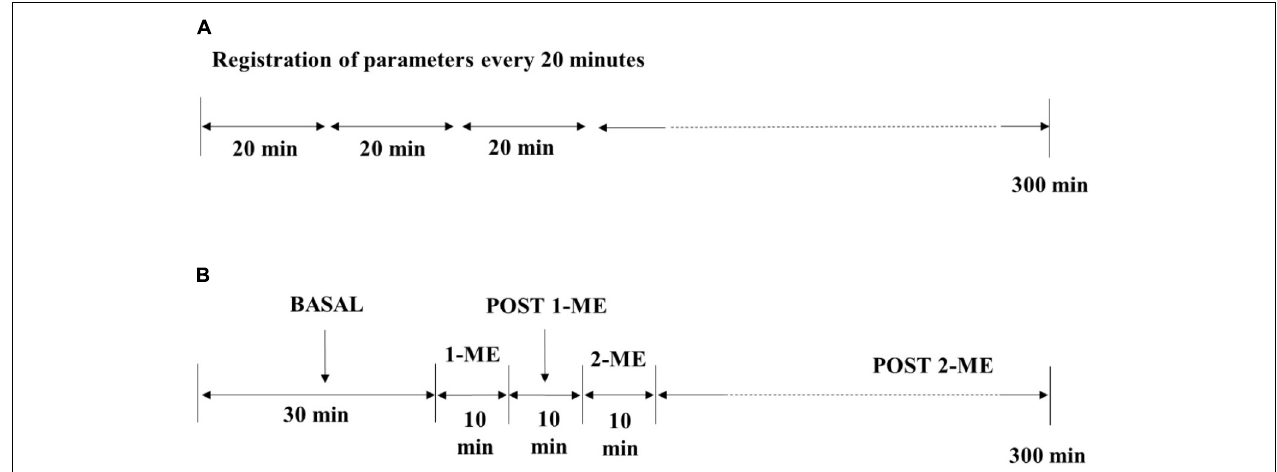
FIGURE 1 | Experimental procedure on SO (A) and 2-ME (B)